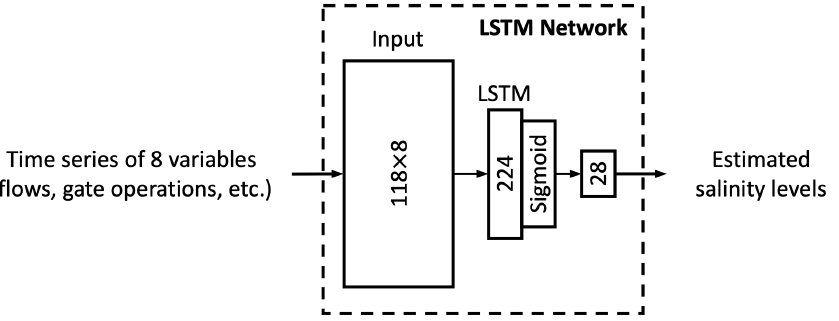
Figure 3. Architecture of the proposed MTL LSTM Network. Numbers in input layer blocks represent the input shape while numbers inside subsequent layers represent the number of units/neurons of the